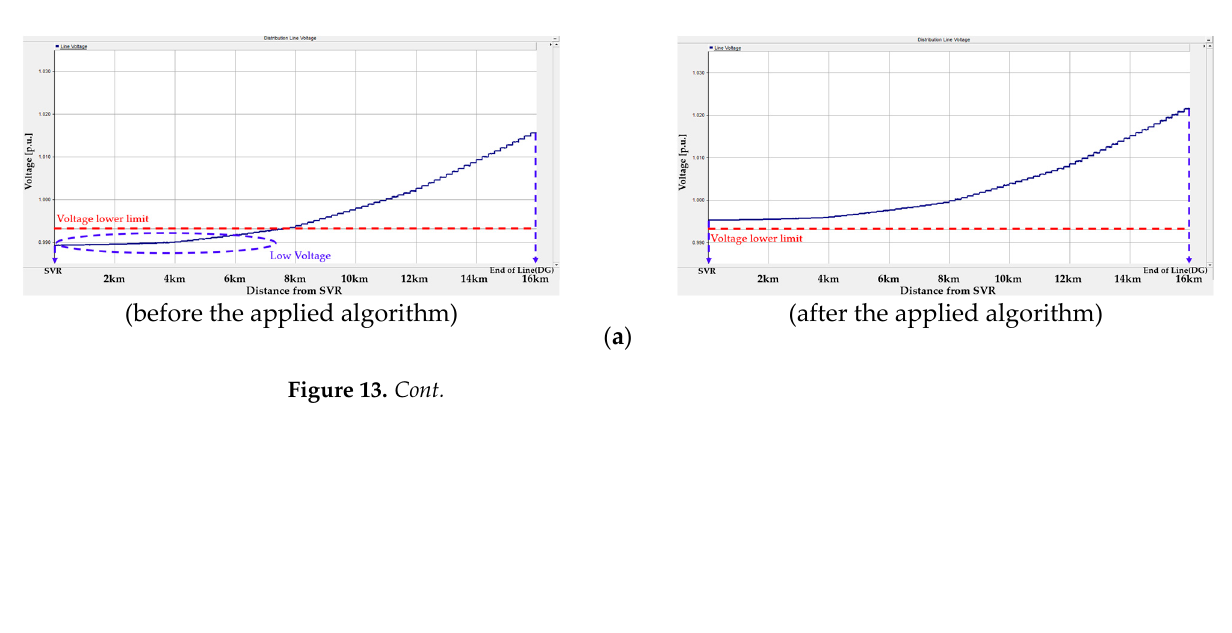
Figure 12. Distribution line voltage profiles by conventional and proposed voltage control in Type 1: ( a ) Case I; ( b ) Case II; ( c ) Case III.